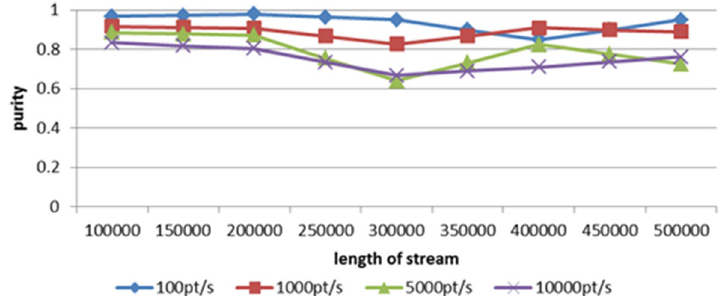
Fig. 18 Effect of stream data rate on purity. In the figure 18, different colors are used to indicate the influence of fourdifferent rates on the clustering